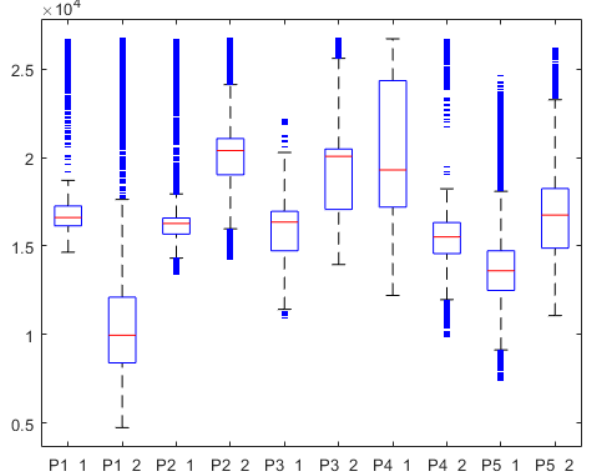
Figure 6. Distribution of measurements data.